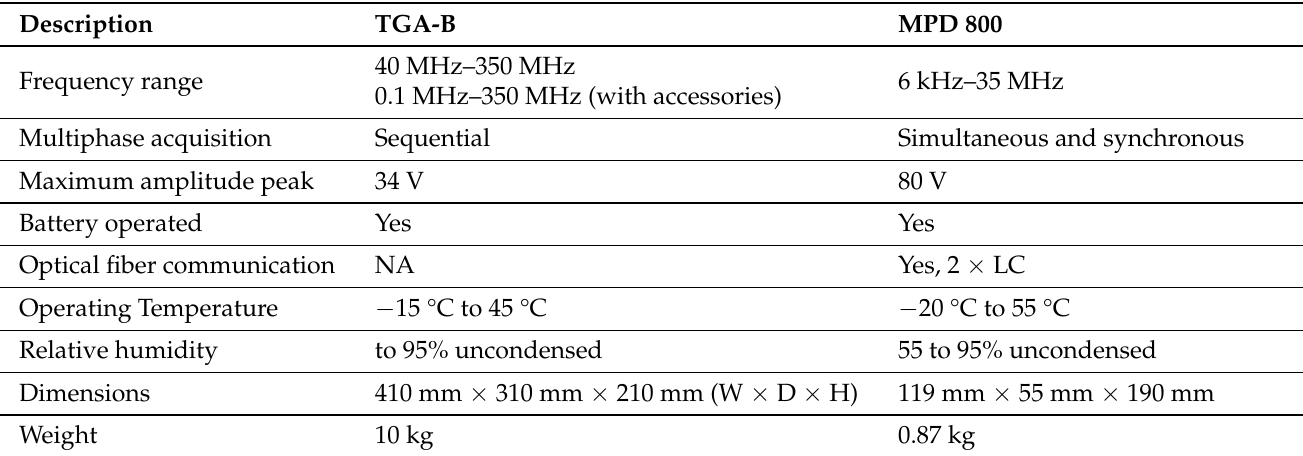
Table 3. Characteristics of the most used commercial equipment.